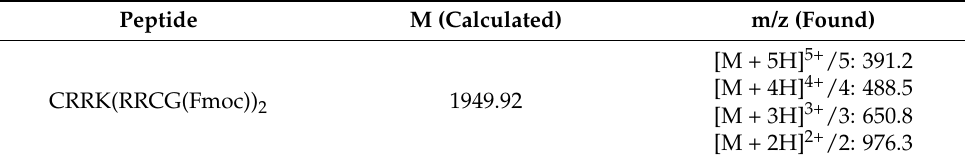
Table 1. ESI-MS analysis of peptide.